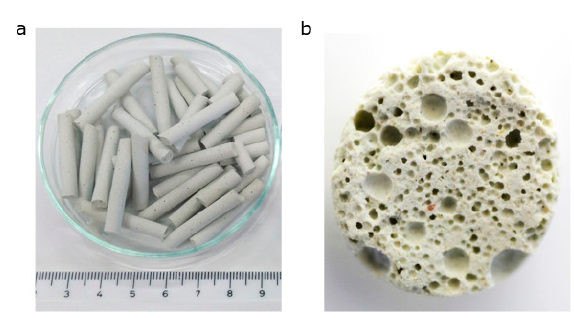
Figure 1. The prepared zeolite foam pellets ( a ) and cross-section of pellet—5 mm diameter ( b